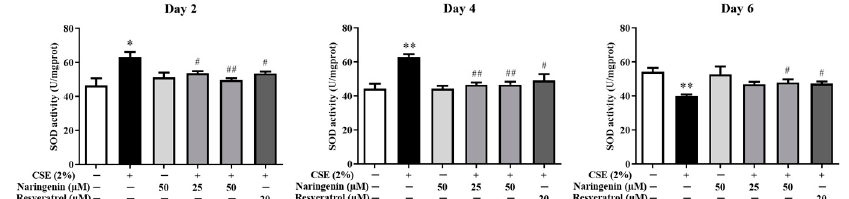
Figure 9. The effect of naringenin on CSE-induced SOD activity in BEAS-2B cells. Data are expressed as the means ± SD of at least three independent experiments for each data point. * p < 0.05, ** p < 0.01 vs. Control group; # p < 0.05, ## p < 0.01 vs. CSE alone group.